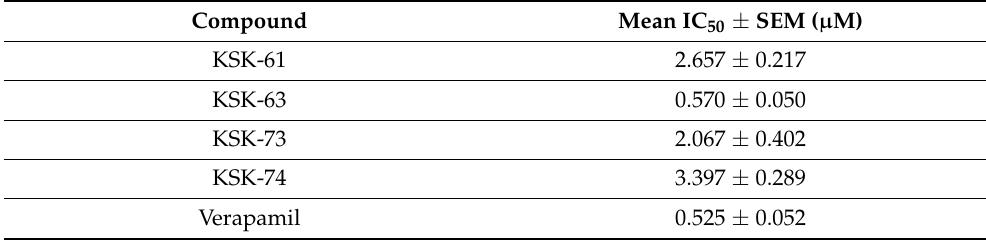
Table 2. Inhibition of hERG currents by tested compounds.